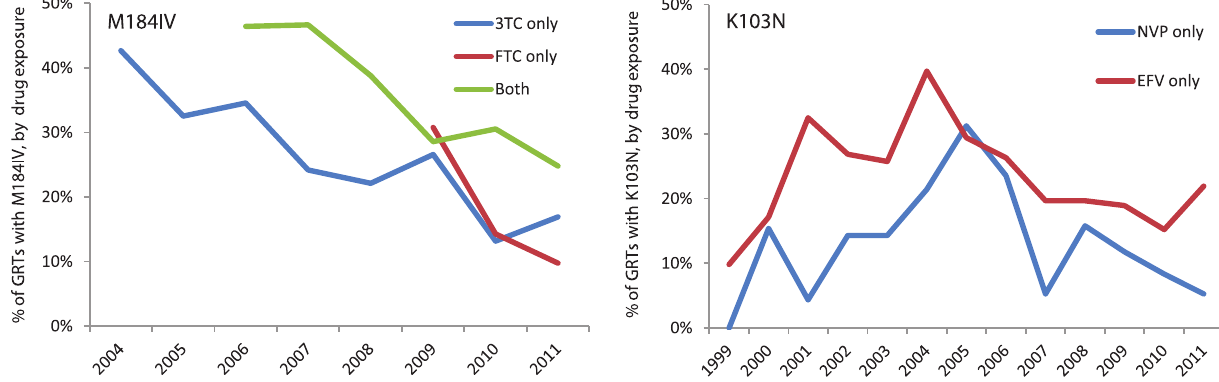
Figure 6. Prevalence of M184IV and K103N by drug exposure. The prevalence of M184IV was divided into patients who had been exposed to 3TC but not FTC (3TC only), FTC but not 3TC (FTC only); or both 3TC and FTC (the graphs show % of GRTs on patients from each group that contained the mutation). No difference could be detected between 3TC only and FTC only, while the patients with exposure to both drugs were more likely to carry resistant virus. In the corresponding graph for K103N it is shown that patients exposed to EFV consistently had higher mutation prevalence compared to patients with NVP. The limited number of patients with exposure to both EFV and NVP had intermediate values and are omitted for clarity.